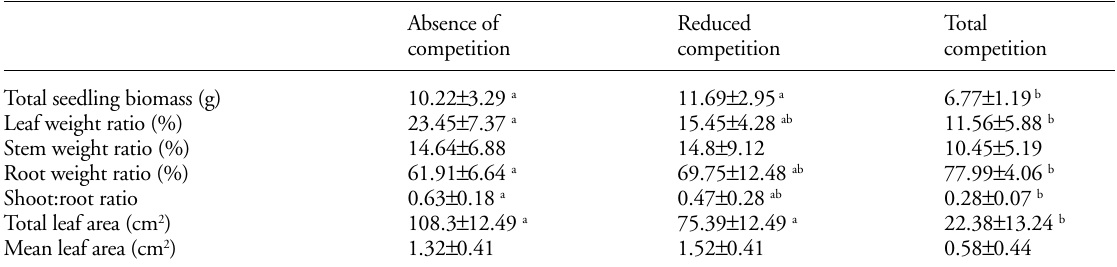
Table 2. Values (mean ± SD) of total seedling biomass in the three competition treatments before the application of the irrigation treatment; leaf, stem, and root weight ratios; shoot:root mass ratio; total leaf area; and mean leaf area. Differences between treatments at p < 0.05 according to a Tukey´s test are indicated with superscripts (note: variable values with no superscripts are not significantly different among